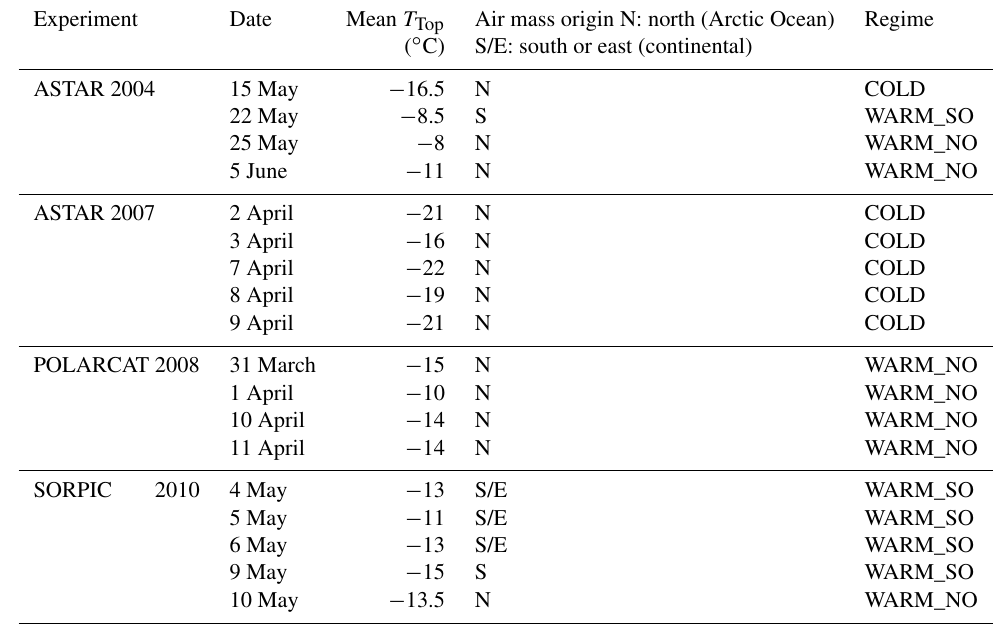
Table 5. Classification of the MPC situations according to temperature regimes and air mass origins. Experiment